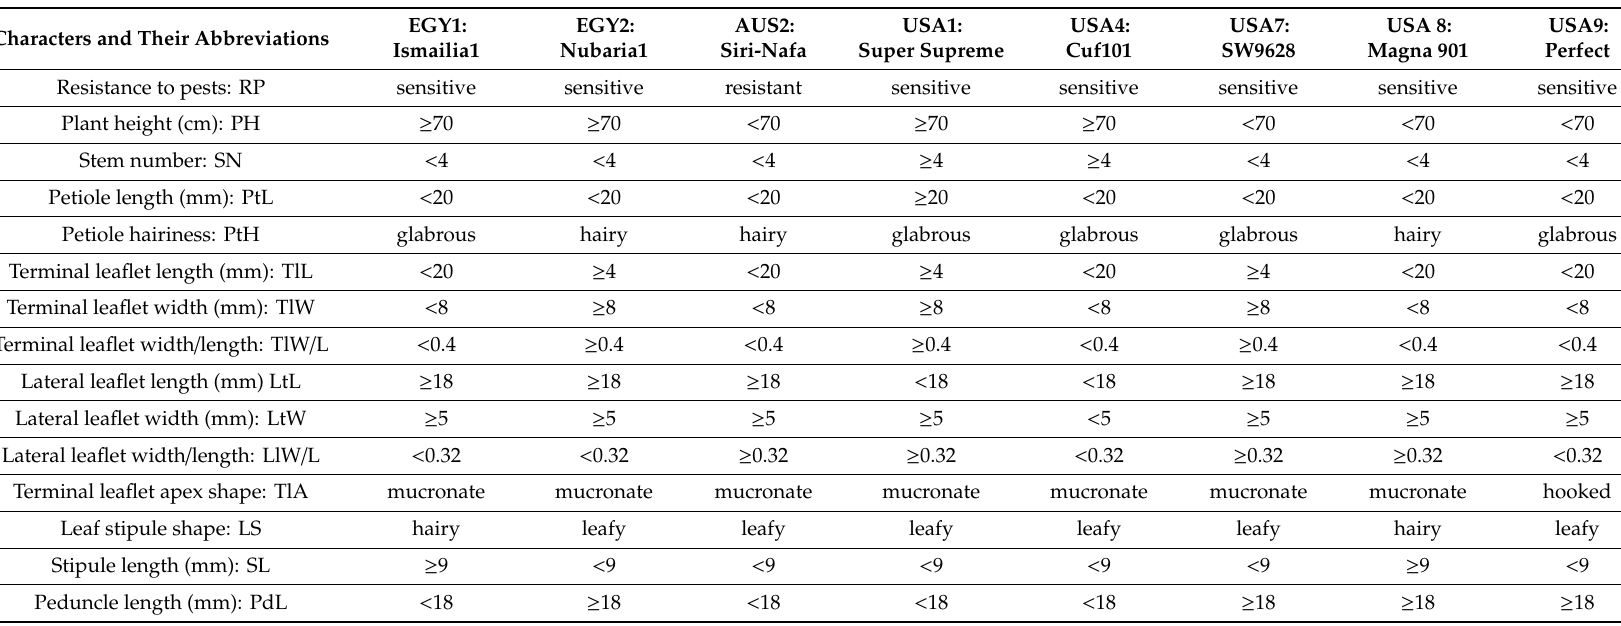
Table 5. List of 16 morpho-agronomic traits and their state in the eight alfalfa cultivars used for phylogeny of these cultivars using mat K and trn H gene